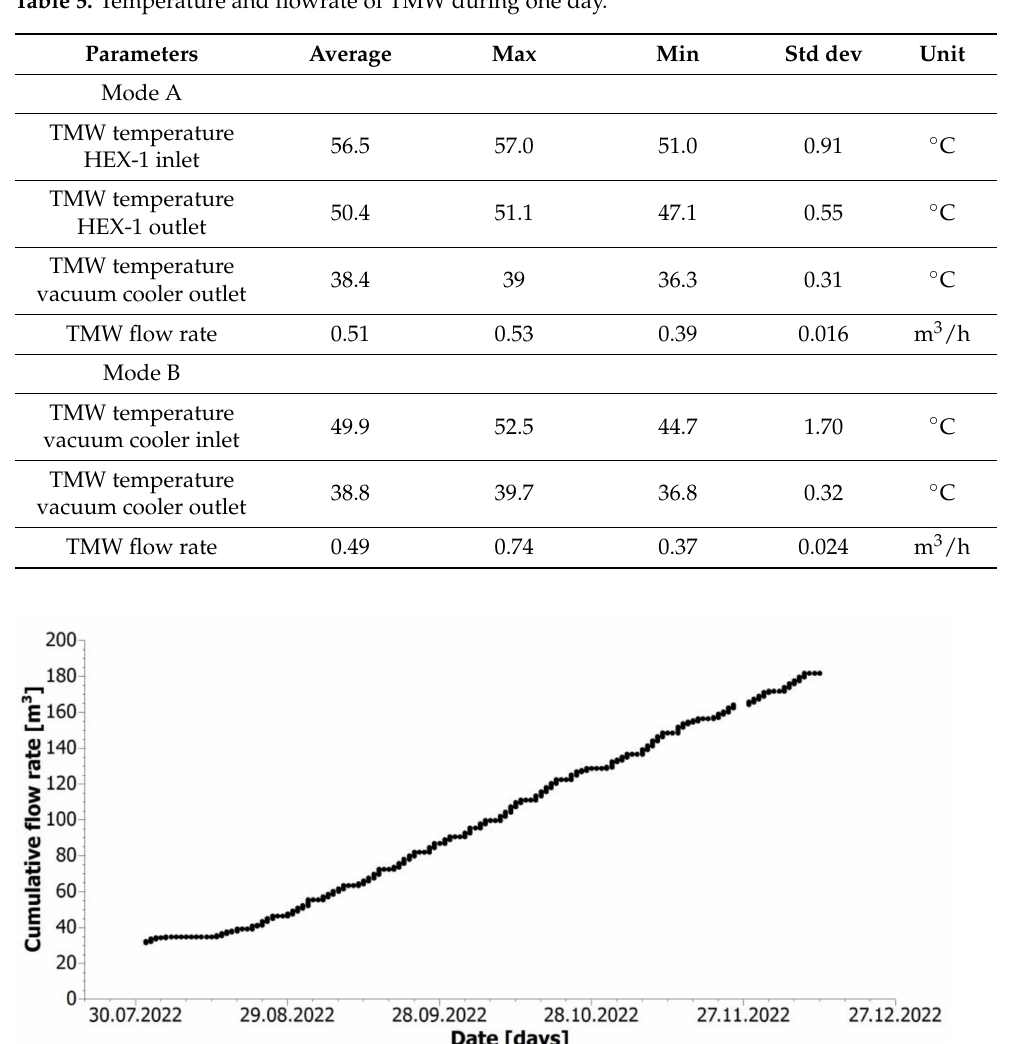
Table 5. Temperature and flowrate of TMW during one day.